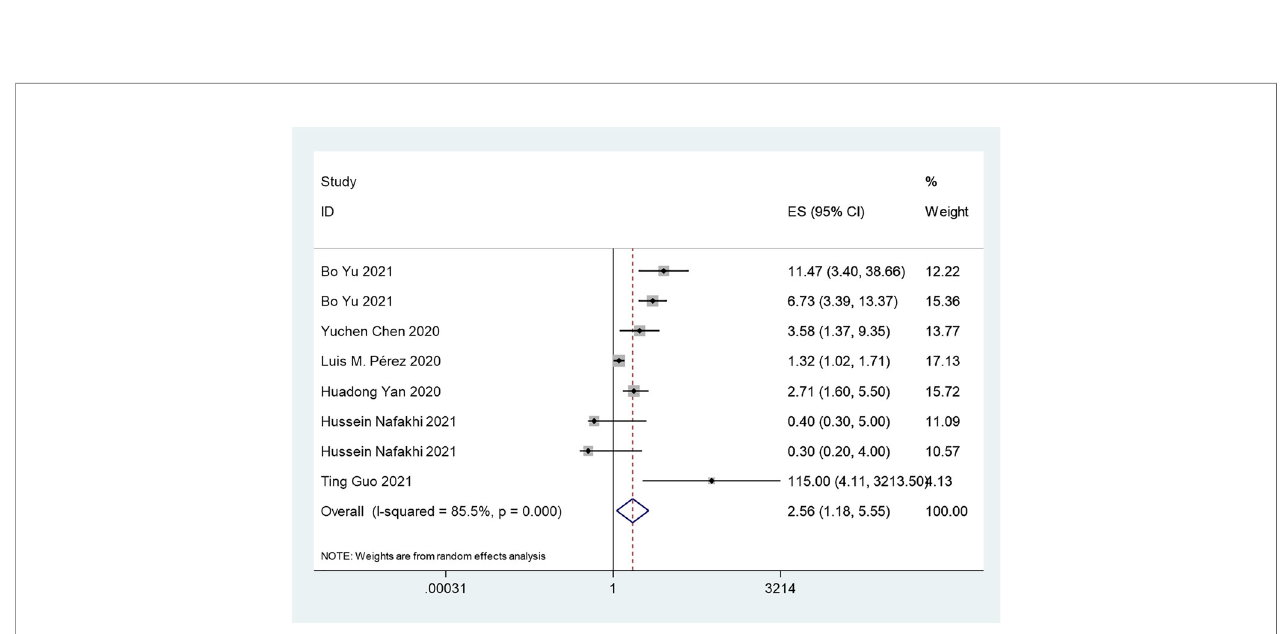
FIGURE 5 | Forest plots of OR for the association between the insulin treatment and the complications of